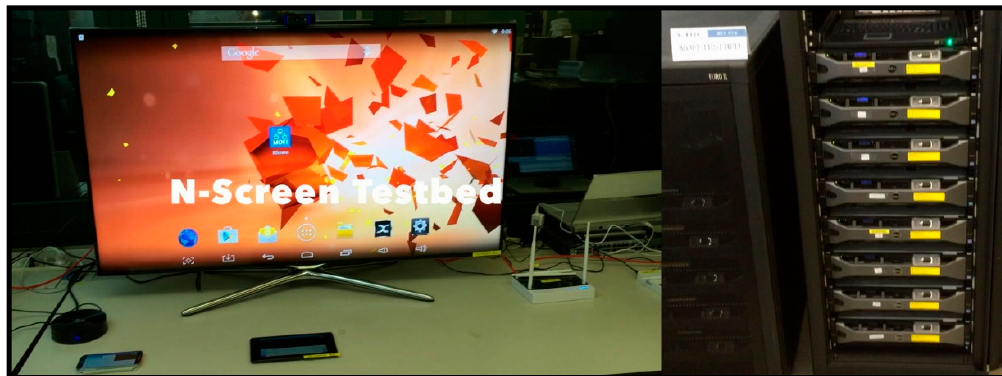
Figure 30. Testbed snapshot for the N ‐ Screen scenario.